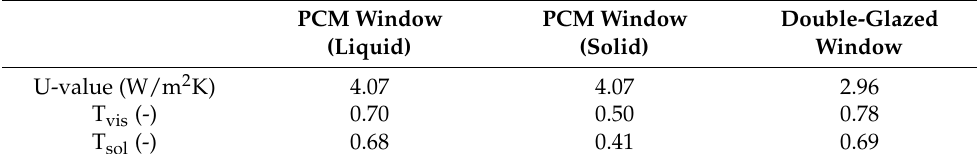
Figure 1. Office dimensions (mm). ( a ) Room with PCM glazing (main); ( b ) Room with a double-glazed window (reference).